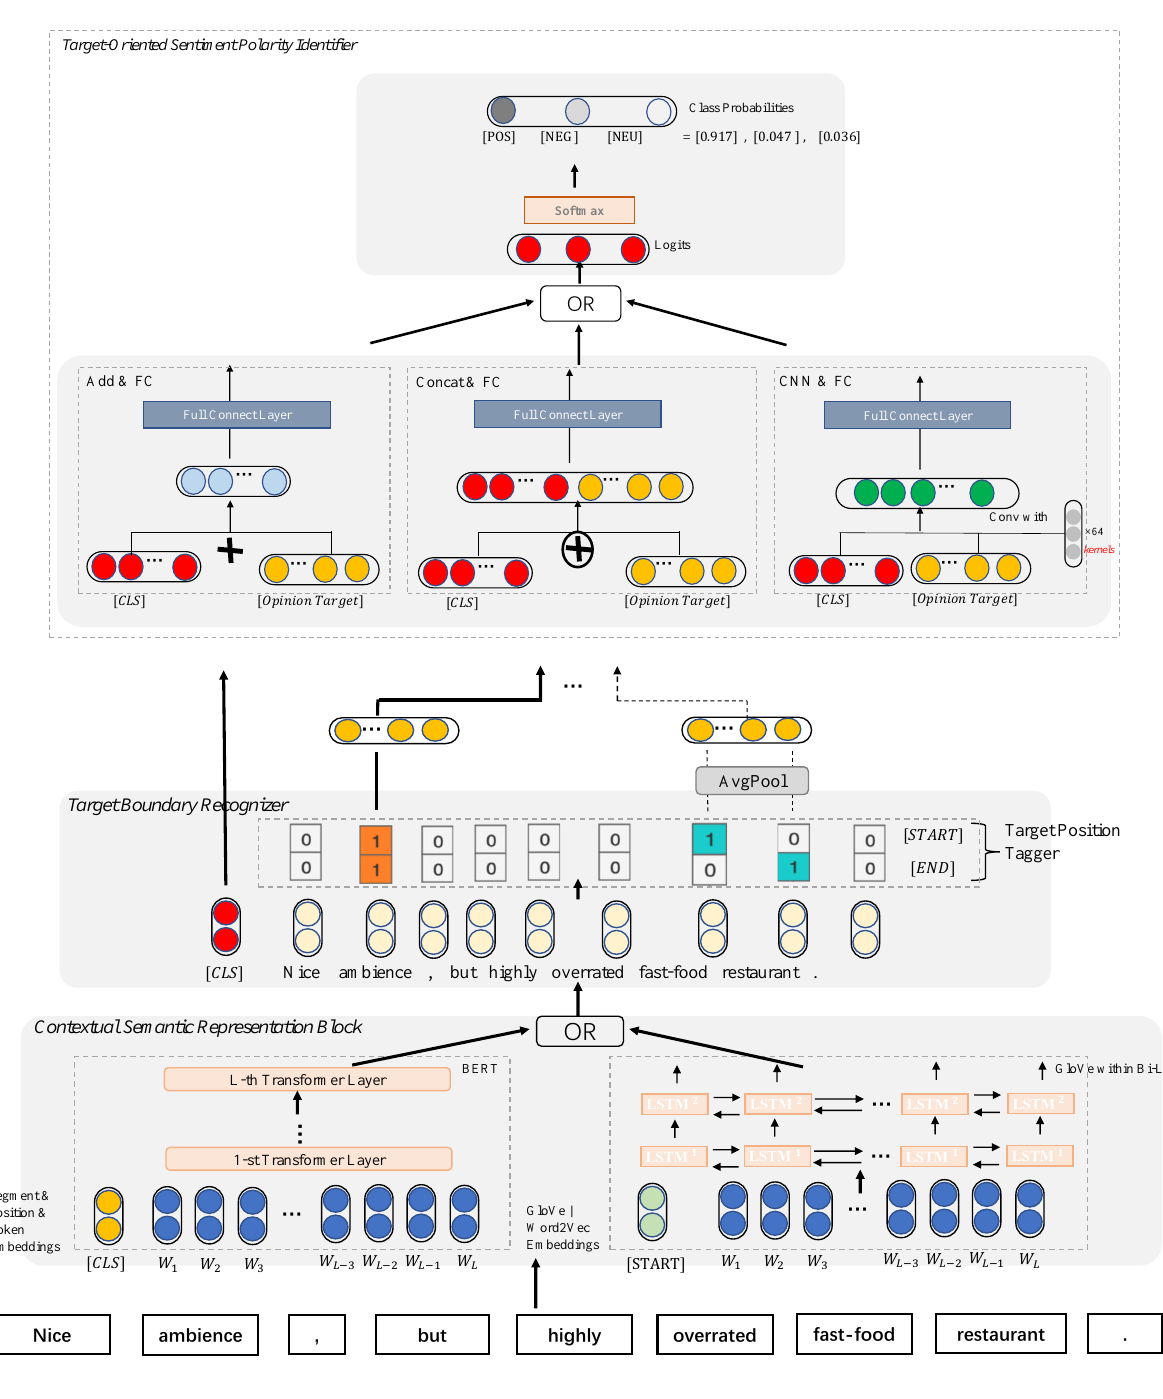
Figure 1. The architecture overview of CasNSA . The three key components CSR, SPI and TBR is shown from bottom to